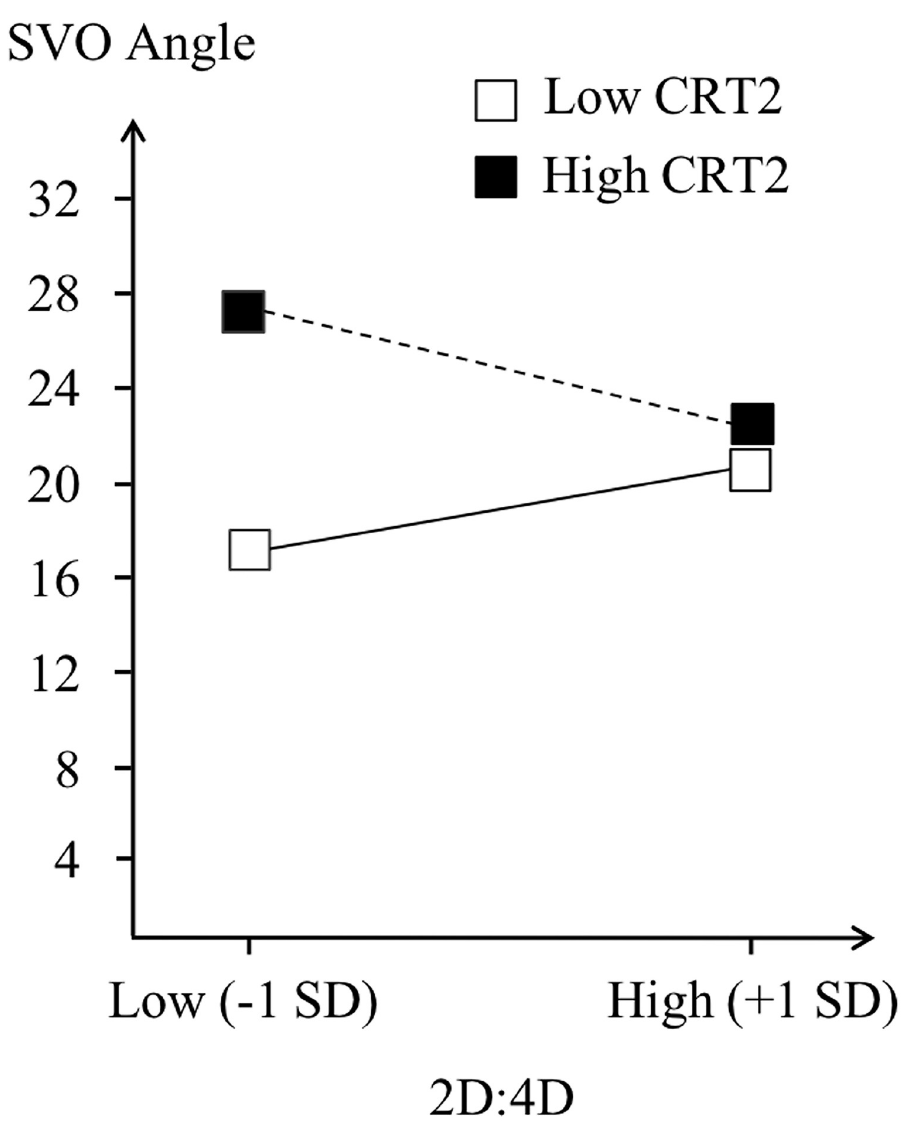
Fig 1. SVO as a function of 2D:4D and CRT-2 (Right-hand male